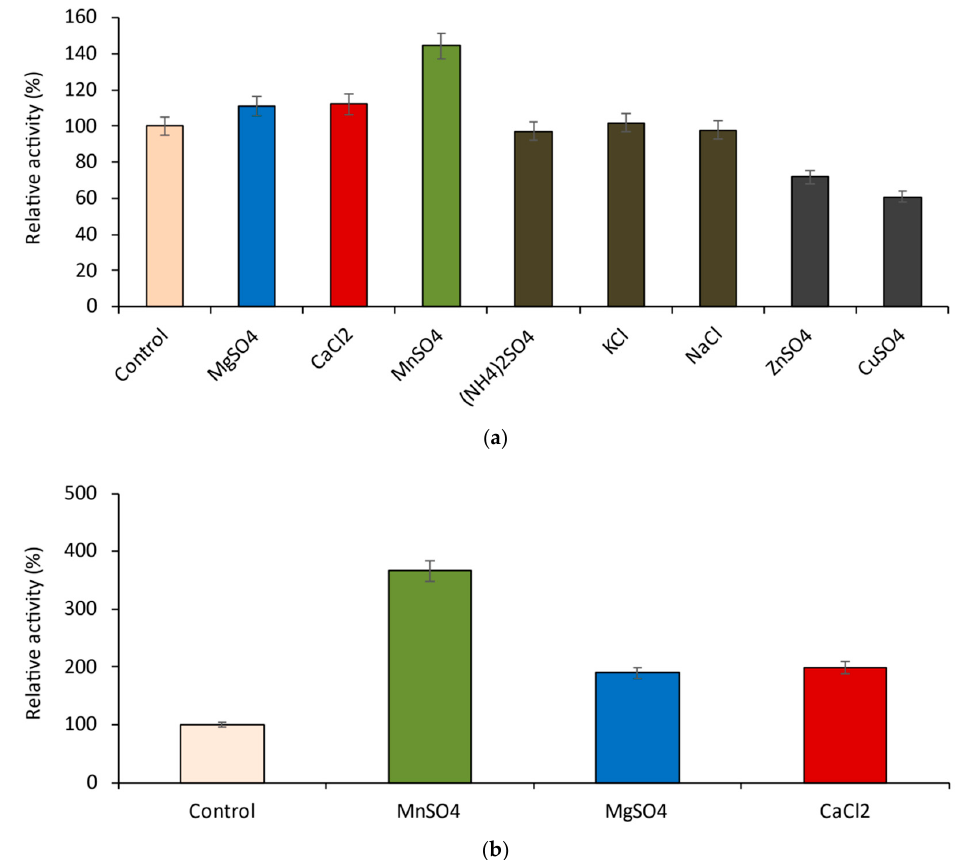
Figure 7. Influence of various cations on the activity of the recombinant β -galactosidase at 10 mM of salts; ( a ) assay conditions: 37 °C and pH 7.0; ( b ) assay conditions: 55 °C and pH 6.5.